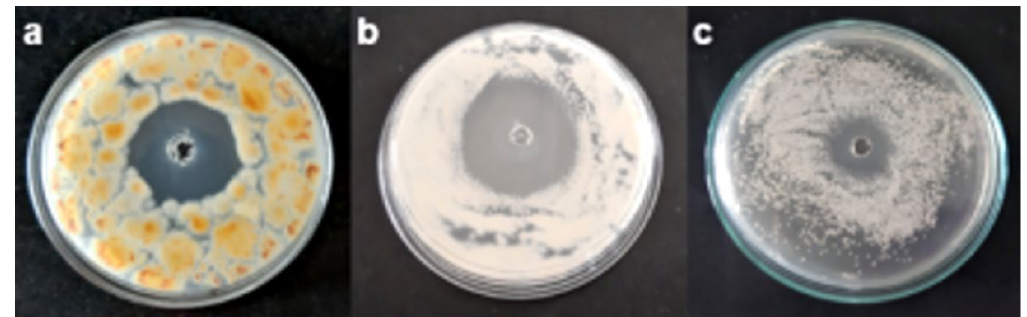
Fig. 2. Antimicrobial activity of lipopeptides extract (LPE) for B. amyloliquefaciens MTCC 10456 by agar well diffusion asssay showing clear zone of inhibition against a T.crustaceus CRS-15 b. N.hiratsukae CRS-16 c. B.subtilis CRS-17